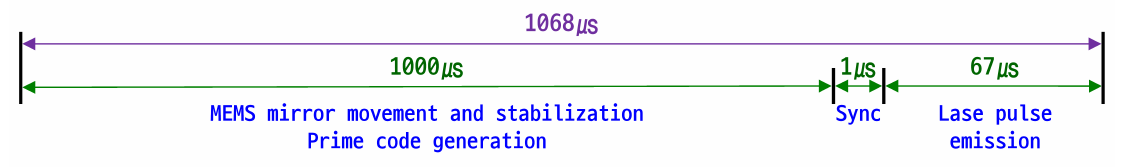
Figure 4. Each pixel has 1068µs for microelectromechanical system (MEMS) mirror movement, prime code generation, synchronous triggering, and laser pulse